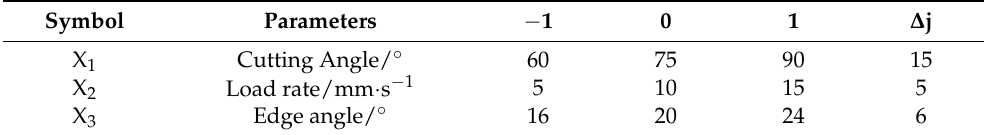
Table 4. Factors and levels of simulation